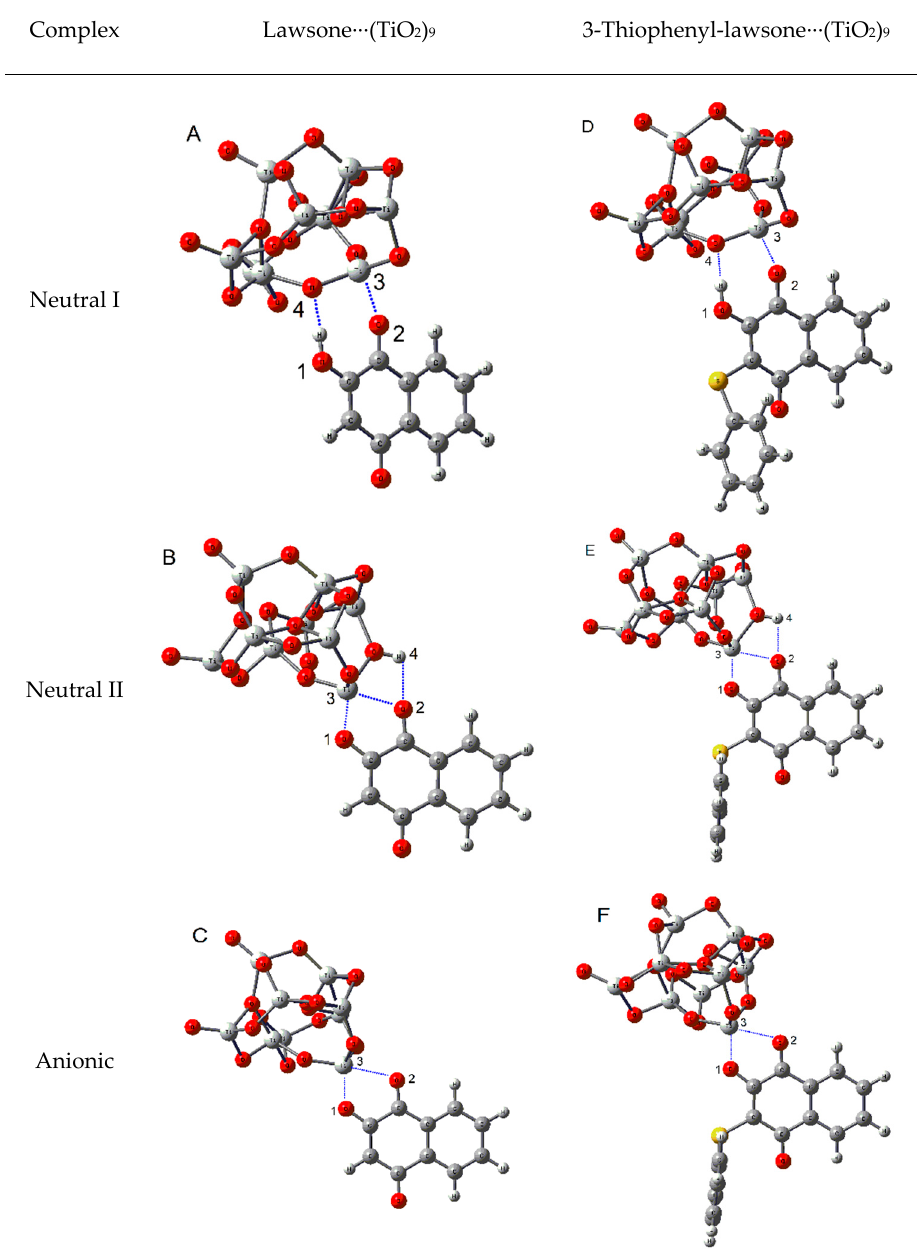
Figure 5. Optimized geometries for the complexes ( A ) neutral lawsone ∙∙∙ (TiO 2 ) 9 , ( B ) neutral deprotonate lawsone ∙∙∙ (TiO 2 ) 9 , ( C ) anionic deprotonated lawsone ∙∙∙ (TiO 2 ) 9 , ( D ) neutral 3-thiophenyl-lawsone ∙∙∙ (TiO 2 ) 9 , ( E ) neutral deprotonated 3-thiophenyl-lawsone ∙∙∙ (TiO 2 ) 9 , and ( F ) anionic deprotonated 3-thiophenyl-lawsone ∙∙∙ (TiO 2 ) 9 . Calculations at B3LYP DFT level with basis set 6-311G(d,p) for C, H, S, and H atoms, and LanL2DZ for Ti atoms.